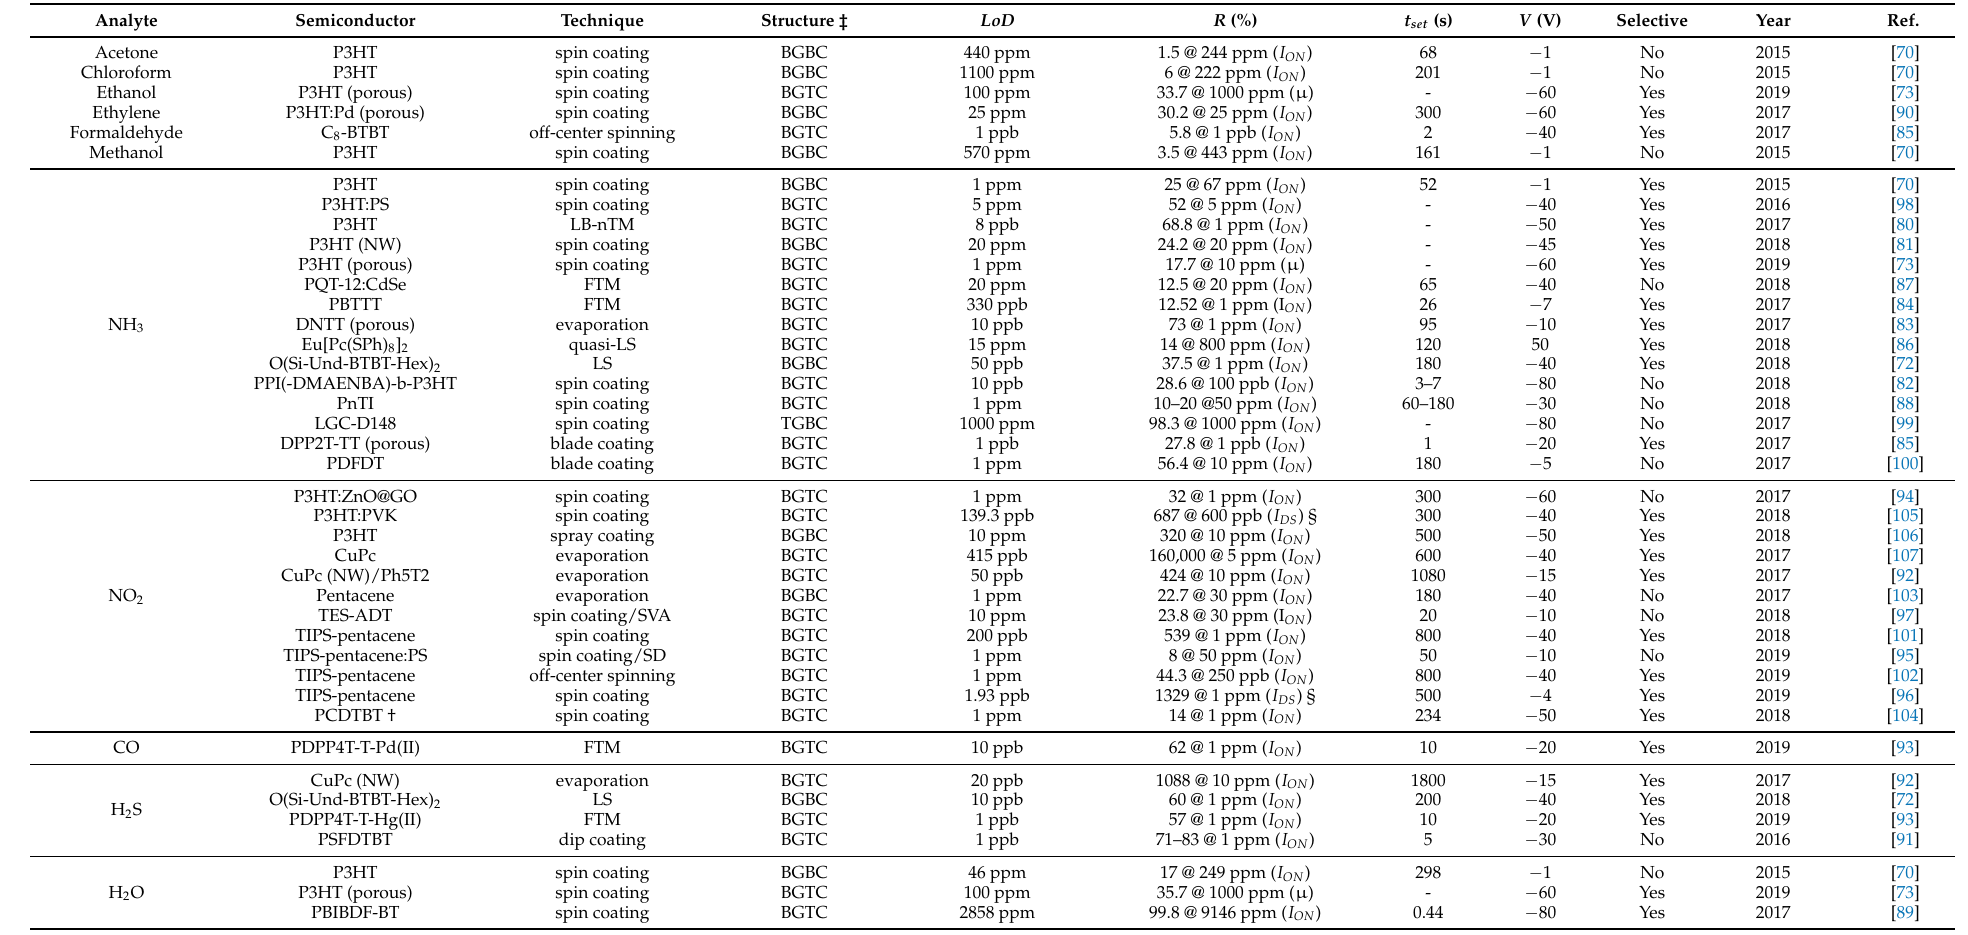
Table 1. Summary of gas sensing performances from organic thin-film transistor (OTFT)-based devices since